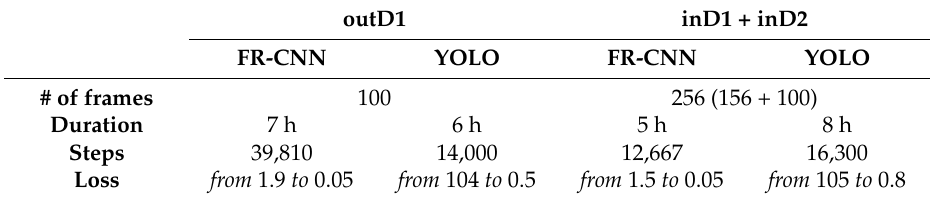
Table 1. Details regarding the training procedure of the FR-CNN and ‘You Only Look Once’ (YOLO) methods.